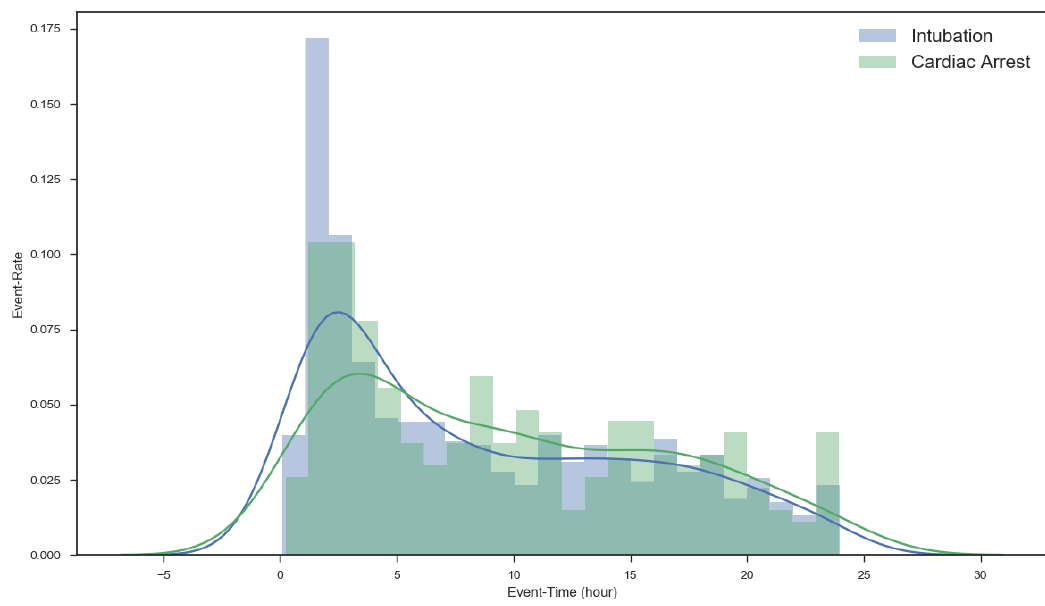
Figure 4. Event distribution after admission.